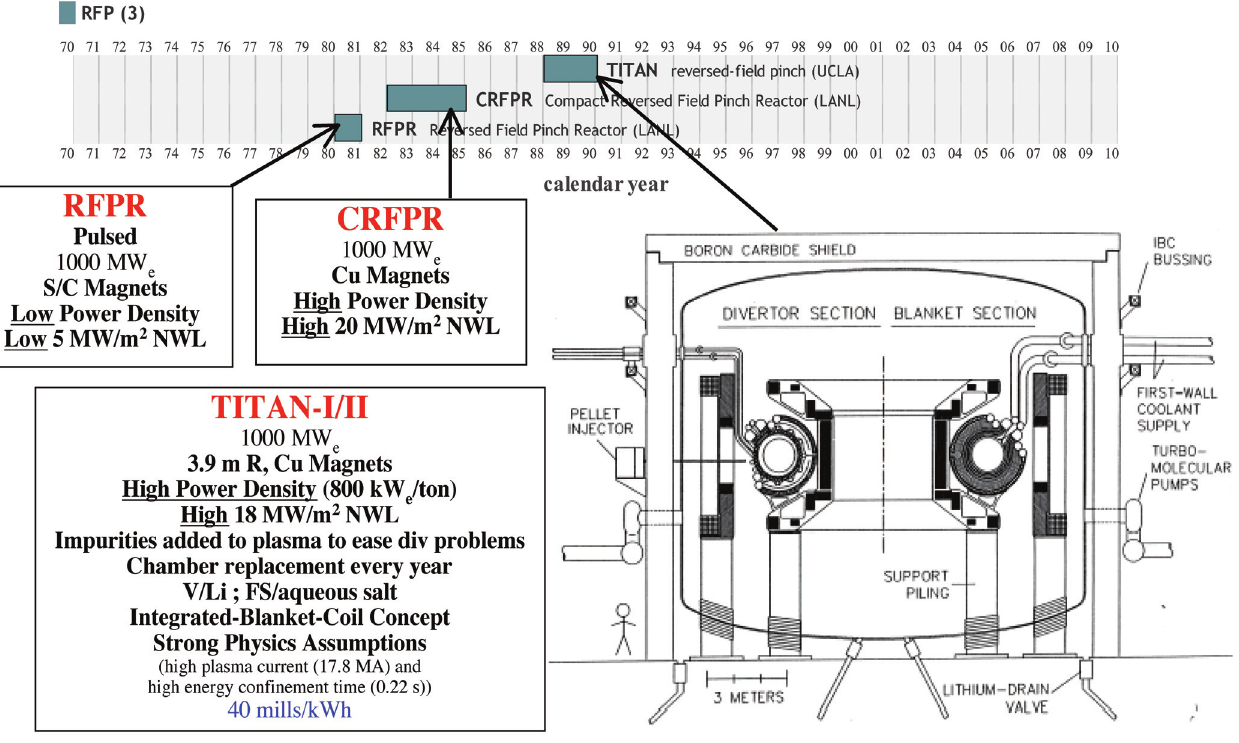
Figure 5. Timeline and main features of reversed-field pinch power plant